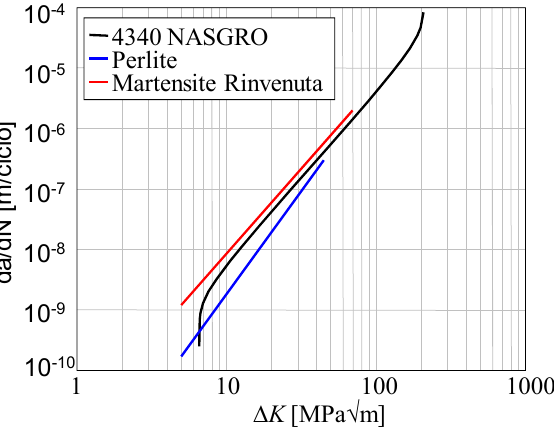
Figura 14: Diagrammi di propagazione di cricche di fatica per un acciaio AISI 4340 temprato e rinvenuto e per campioni di acciaio 1.2738 costituiti da varie strutture metallografiche. Figure 14: Fatigue crack propagation rate diagrams obtained with quenched and tempered AISI 4340 steel samples and with